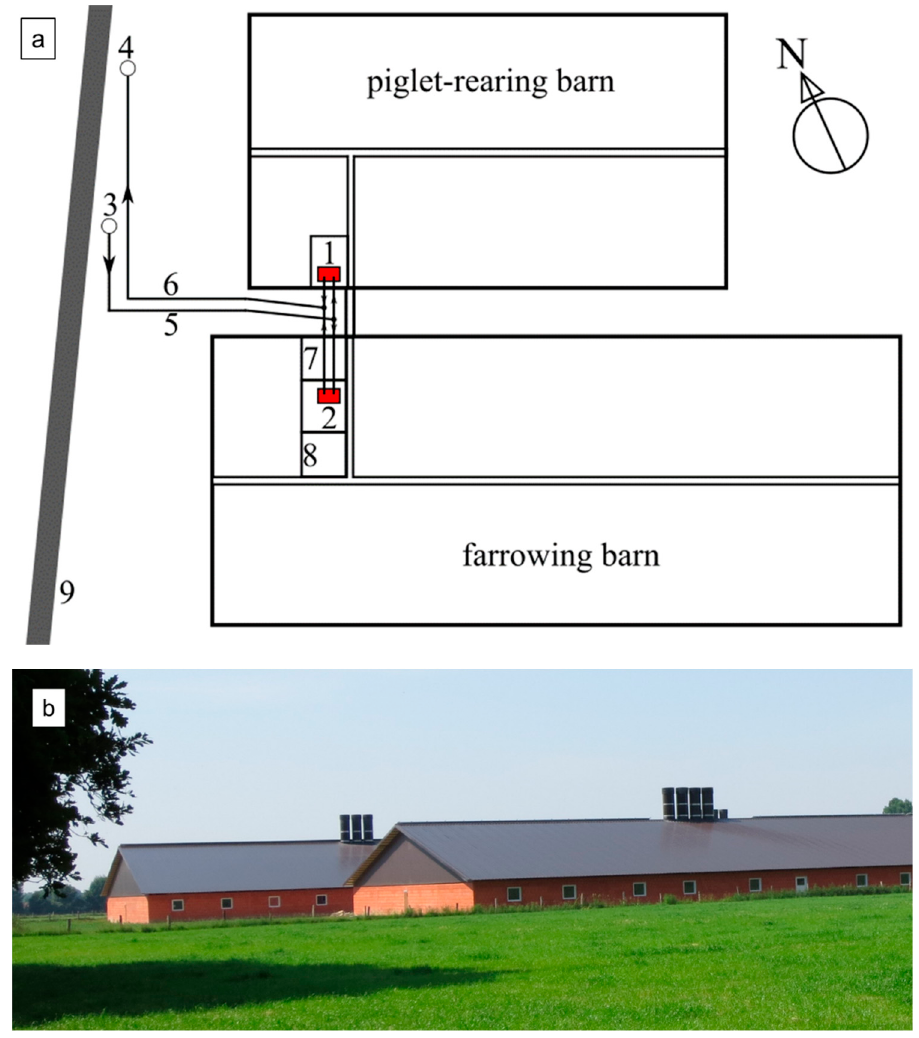
Figure 2. ( a ) Sketch of the floor plan of the barn and ( b ) exterior view of the barn from the north-west side. 1: heat pumps piglet-rearing barn; 2: heat pump farrowing barn; 3: extraction well